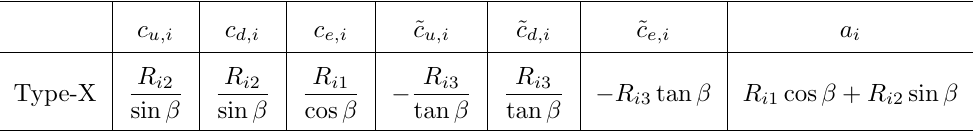
Table 1 . The multiplicative factors of Yukawa interactions in type-X